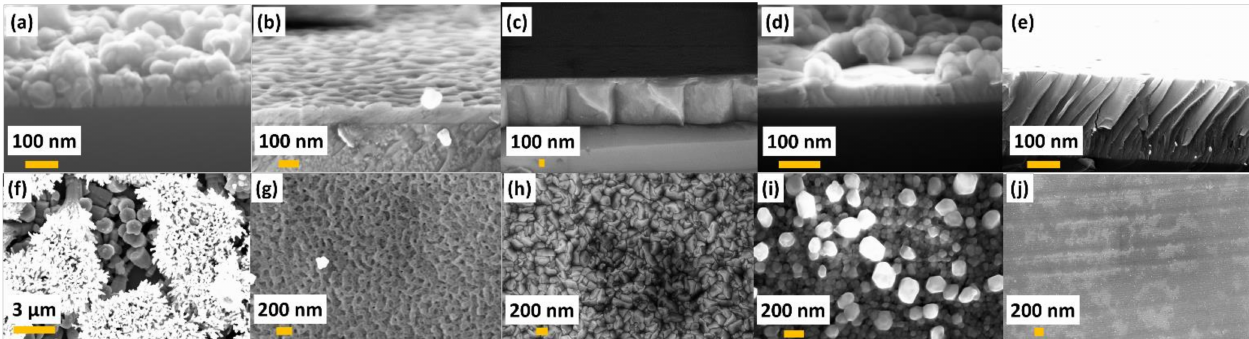
Figure 1. Cross-sectional ( a – e ) and top-view ( f – g ) SEM images of ZnO layers grown on SiC substrates with different off-cut angles: 0 ◦ ( a , f ), 1.4 ◦ ( b , g ), 2 ◦ ( c , h ), 3.5 ◦ ( d , i ), and 8 ◦ ( e , j ),